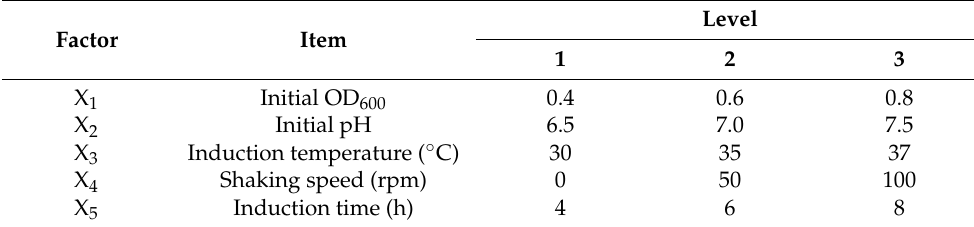
Table 2. Factors and levels for the orthogonal test to optimize the induction conditions. Factor Item